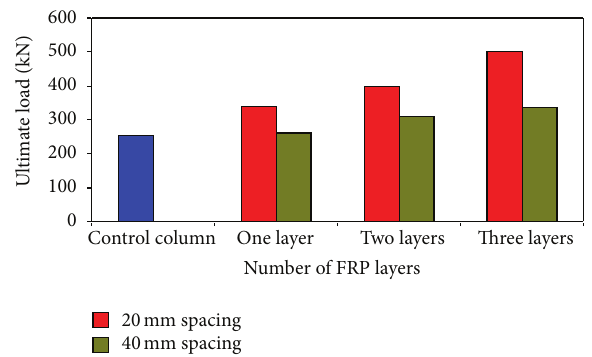
Figure 18: Ultimate axial strength of all strengthened columns, comparison.